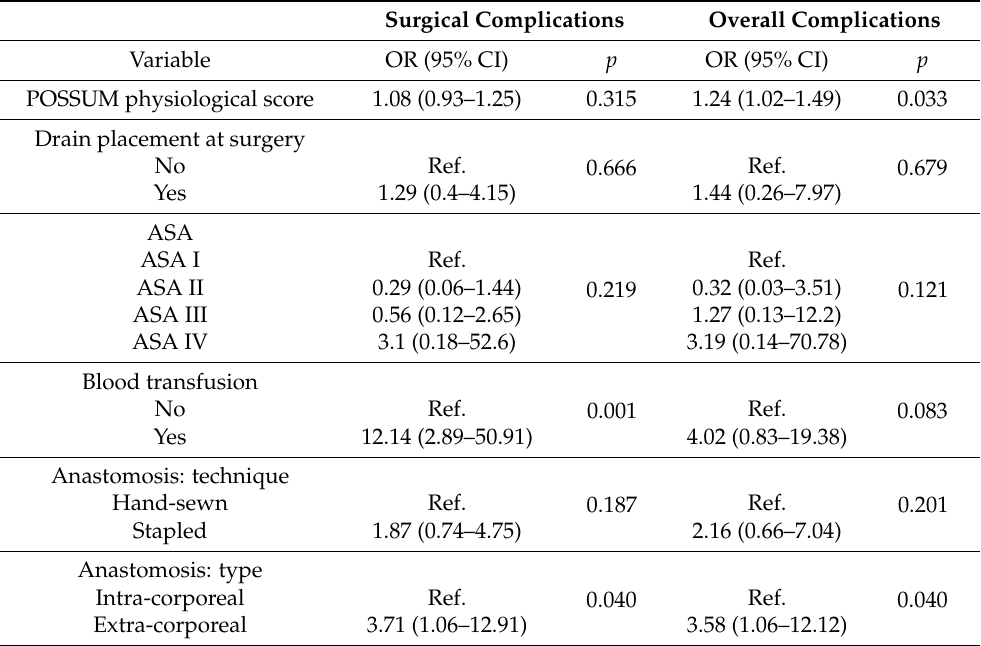
Table 3. Multivariable analysis for surgical and overall complications. Odds Ratio > 1 is associated with increased